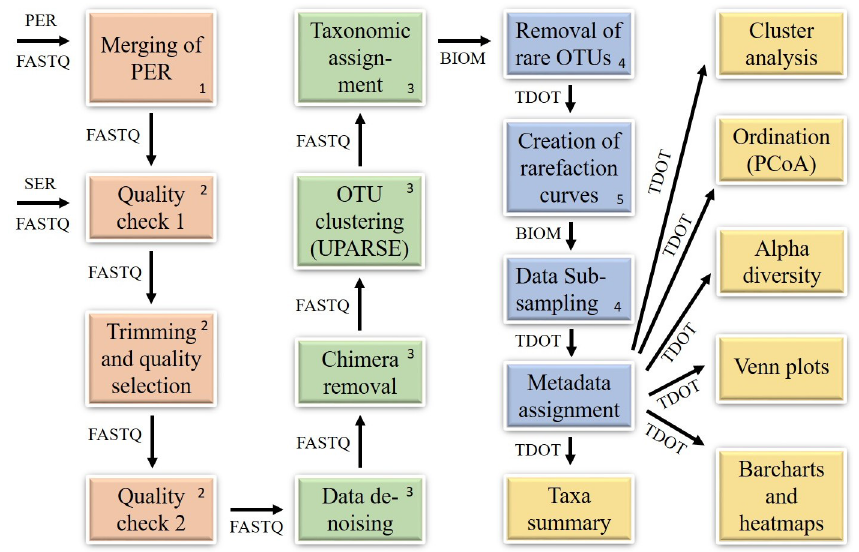
Fig 1. Overview of the CoMA pipeline workflow. Different colors represent the four sub-sections of the CoMA workflow: Data pre-processing and quality checking (orange), clustering of operational taxonomic units (OTUs) and taxonomic assignment (green), data post-processing (blue) and data visualization and statistical appraisal (yellow). Labelled arrows demonstrate the order of events and name specific file types that are needed as input for each step. Taxonomic assignment is done with Blast, Lambda or RDP using either one of the available databases (e.g. Silva [23]) or any custom database provided by the user. Numbers indicate third party tools that are used for the specific CoMA step: 1 = PANDAseq, 2 = PRINSEQ, 3 = LotuS/sdm, 4 = QIIME, 5 = Mothur. TDOT = Tab-delimited OTU-table. PER = Paired-end reads. SER = Single-end reads. PCoA = Principal coordinates